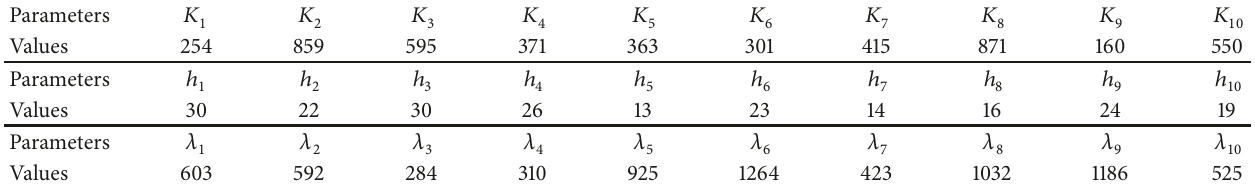
Table 3: The values for 𝐾 𝑖 , ℎ 𝑖 , and 𝜆 𝑖